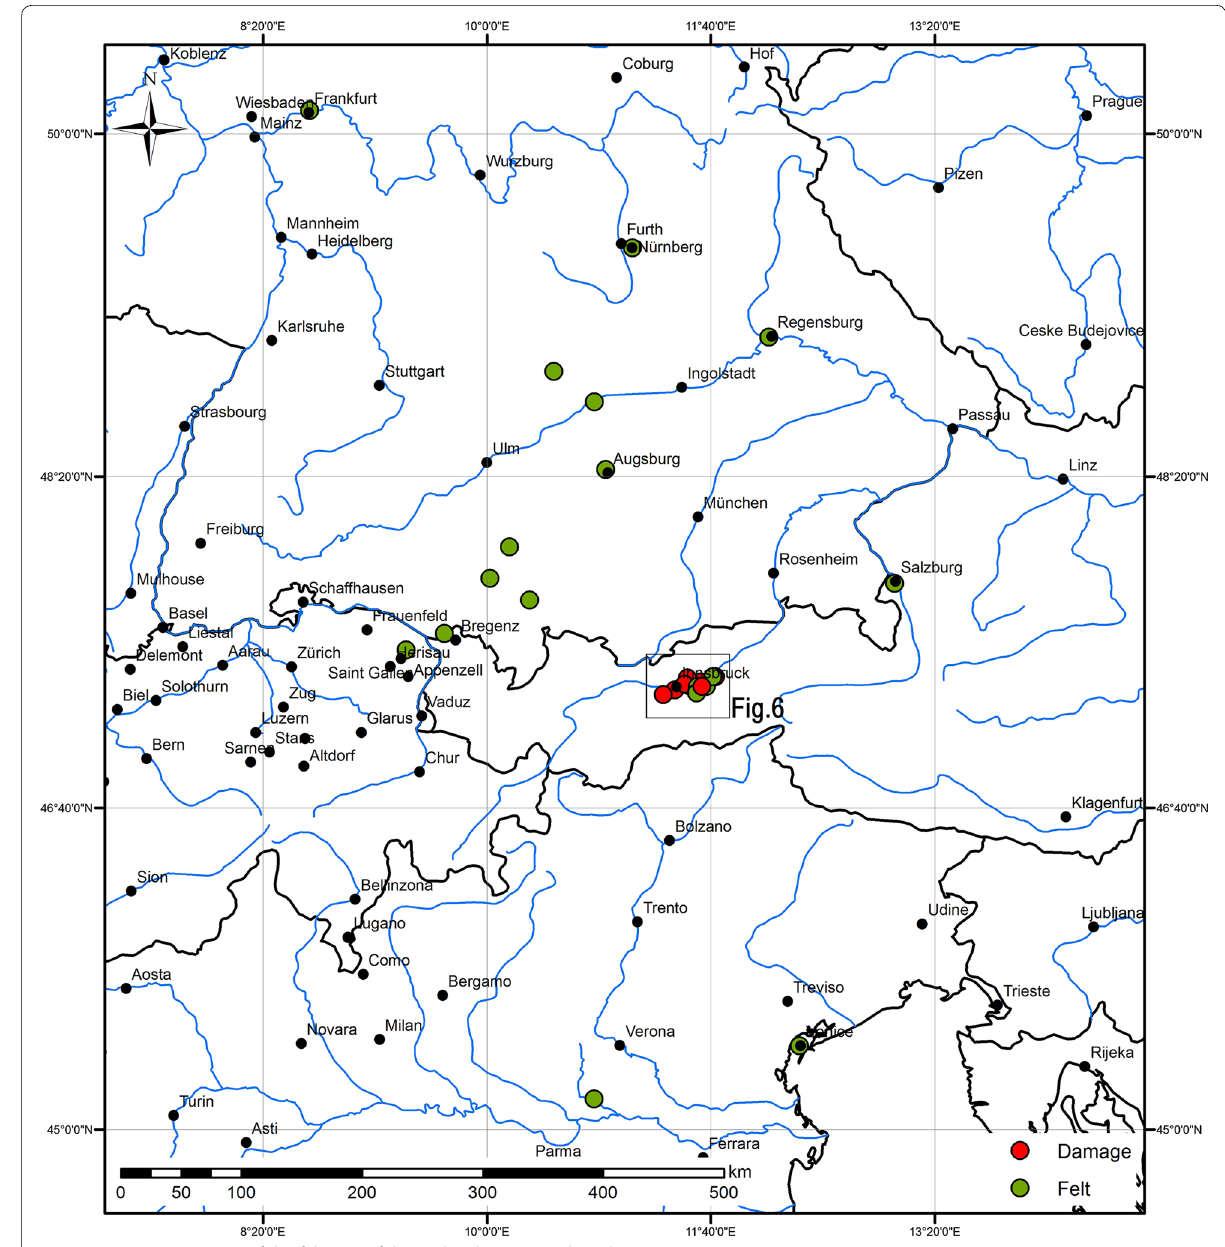
Fig. 5 Macroseismic map of the felt area of the 17th July 1670